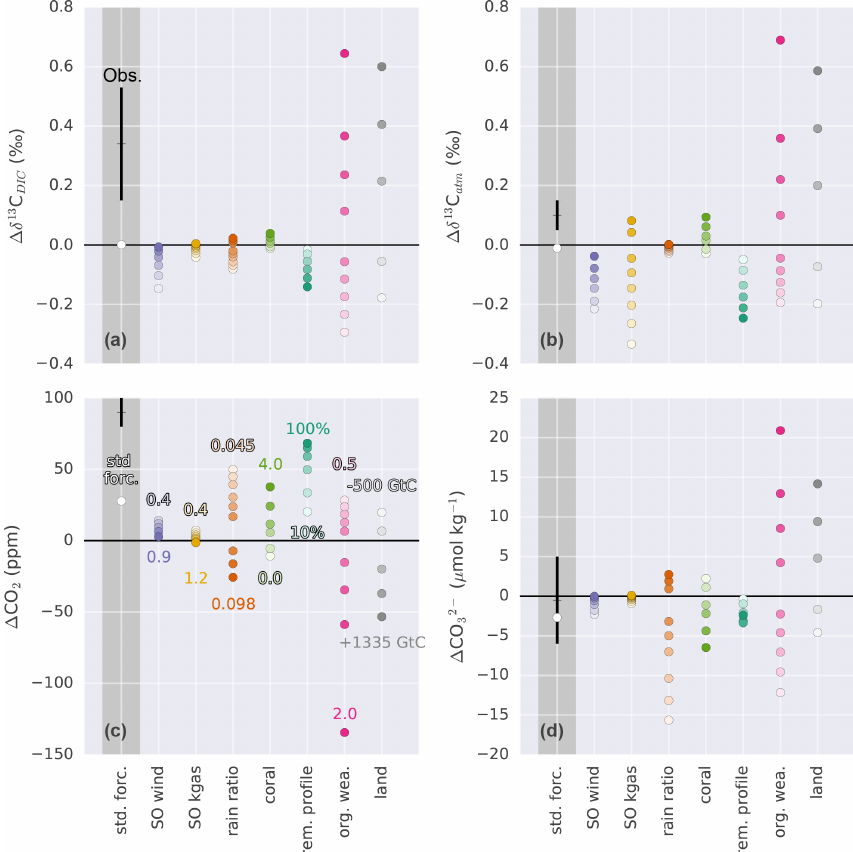
− to changes in Southern Ocean wind stress (SO wind), Figure 7. Sensitivity of (a) (cid:49)δ 13 C DIC , (b) (cid:49)δ 13 C atm , (c) (cid:49) CO 2 , and (d) (cid:49) CO 2 3 Southern Ocean gas transfer rate (SO kgas), export rain ratio, shallow water carbonate deposition (coral), remineralization profile (rem. profile), organic weathering flux (org. wea.), and land carbon uptake (land). Sensitivities are shown relative to the standard forcings (white dots). Values in panel (c) correspond to the entries in Table 2. Black crosses with error bars show estimates based on measurements ( (cid:49) CO 2 : Petit et al., 1999; Monnin et al., 2001; Siegenthaler et al., 2005; Lüthi et al., 2008; Köhler et al., 2017; (cid:49)δ 13 C atm : Schmitt et al., 2012; (cid:49) CO 2 − : Yu et al., 2013; Qin et al., 2017; Luo et al., 2018; (cid:49)δ 13 C DIC : Peterson et al., 2014). Dots in dark grey shading show absolute and 3 in light grey shading relative (to standard forcings) values. (cid:49) indicates the PI–LGM